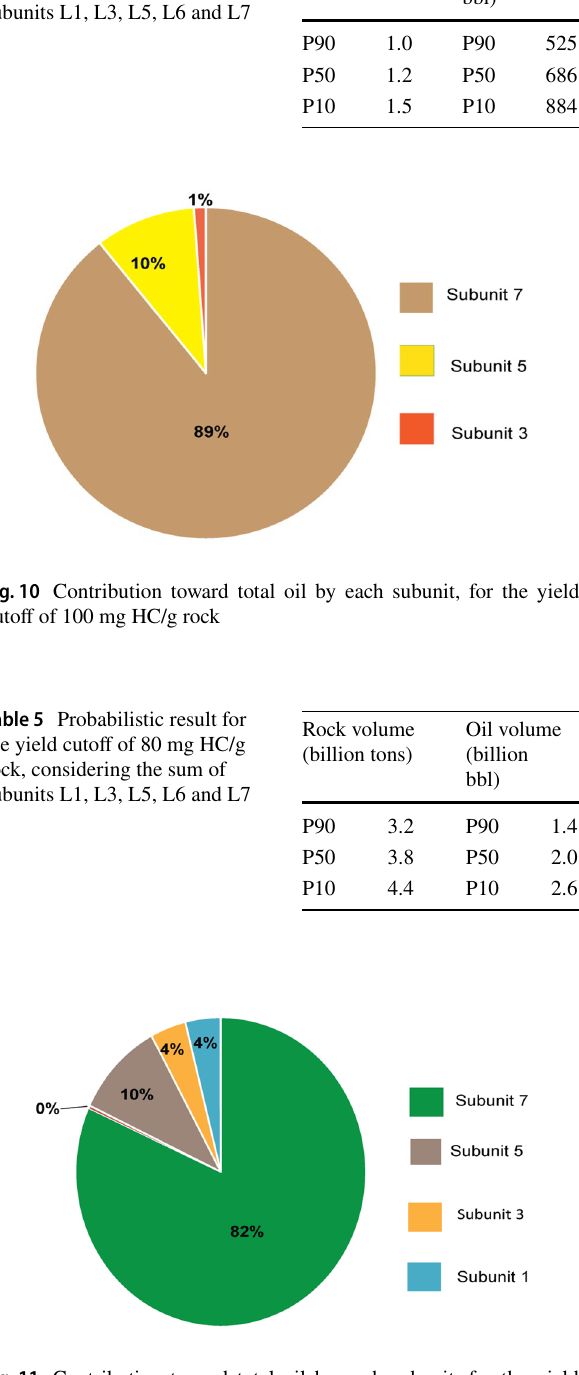
Fig. 11 Contribution toward total oil by each subunit, for the yield cutoff of 80 mg HC/g rock